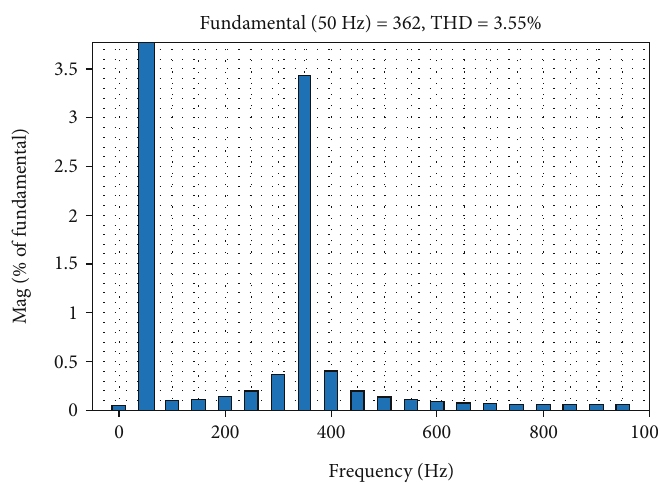
Figure 38: THD values for microgrid current load.